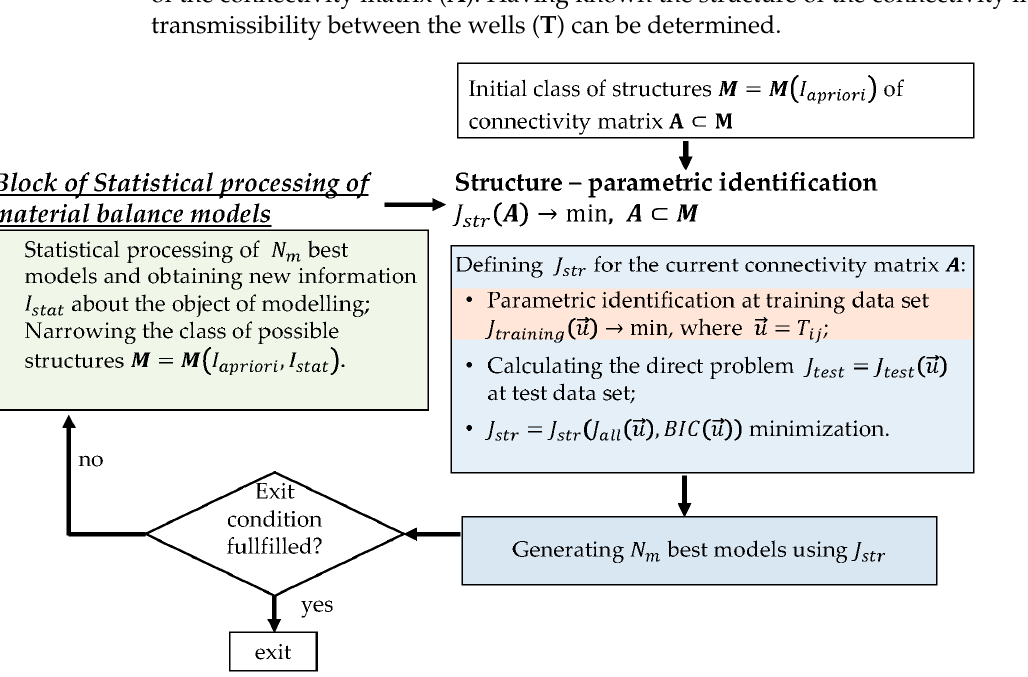
Figure 5. Block diagram of the methodology for structural-parametric identification of the material balance model.